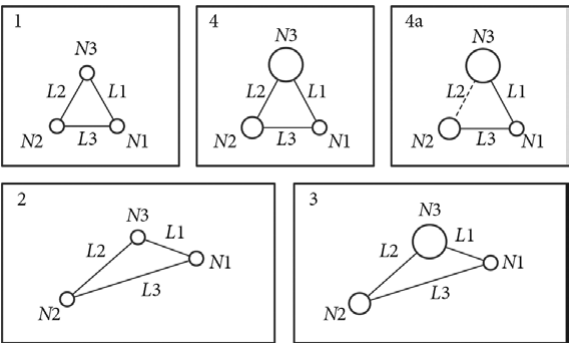
Fig. 2. Different cases illustrating four types of habitat patch connectivity and one case illustrating change corresponding to the loss of non-cutlink or corridor Table 1. Input data. Area of particular habitat patch ( N ) and the length of particular link ( L ) for all cases Case No. Node/Link